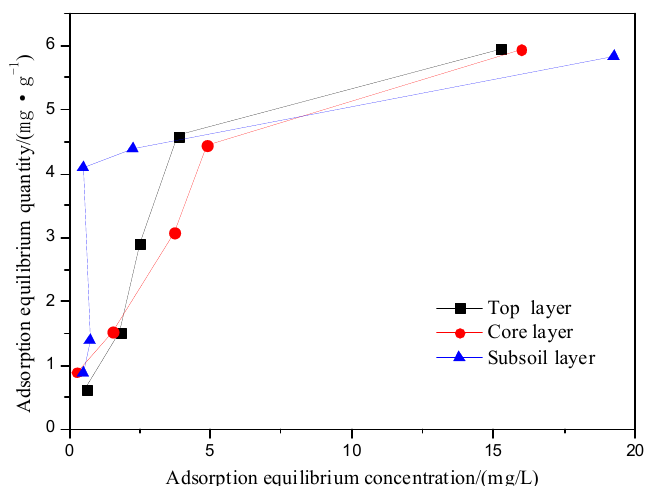
Figure 5. Adsorption Isothermal curve. (4 mg of soil, initial concentration of Fe 3+ was 100, 200, 300, 400 mg·L − 1 and the initial pH was 4.20, 25 °C). Table 3. Adsorption Isothermal Parameters.